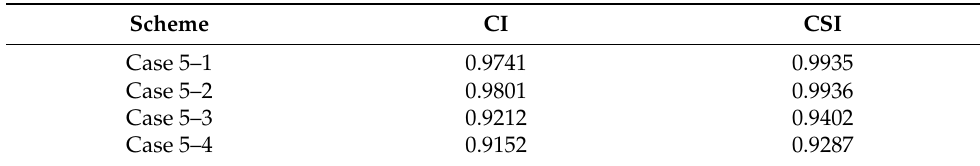
Figure 4. The prescribed and inverted distributions of WSDCs after adding 3%, 5%, 10%, and 15% er- rors. Subfigures ( a ), ( b ), ( c ) and ( d ) represent the addition of 3%, 5%, 10% and 15% errors, respectively. Table 6. The correlation coefficients between the prescribed and inverted WSDCs with different schemes in different